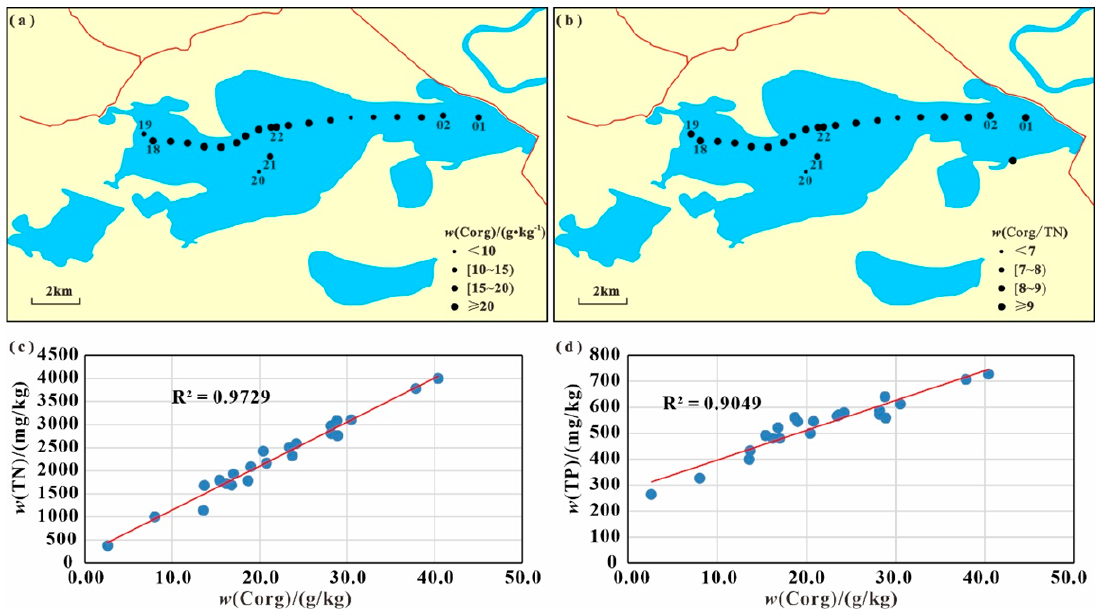
Figure 3. Distribution diagram of Corg ( a ), Corg/ TN ( b ) and the scatter plot of Corg- TN ( c ) and